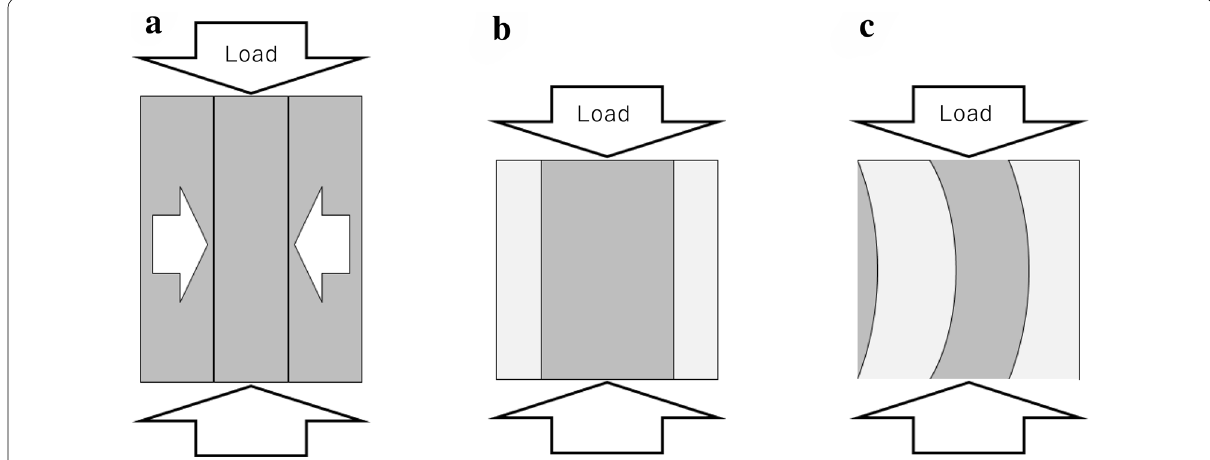
Fig. 12 Deformation models of the hard species veneer of LVL in the compression tests; a plane-strain model in the mono-species LVL, b plane-stress model in the mixed-species LVL, c buckling model in the mixed-species